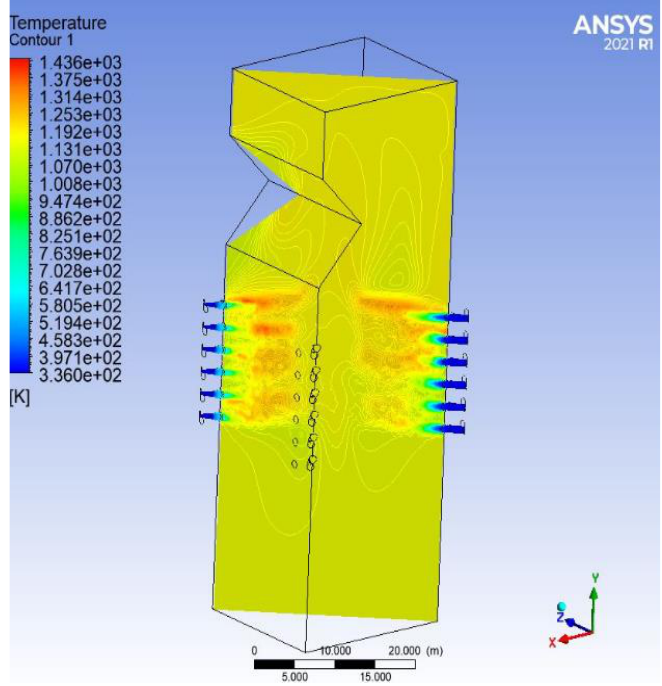
Figure 10. Temperature distribution of flue gas in case-IV.